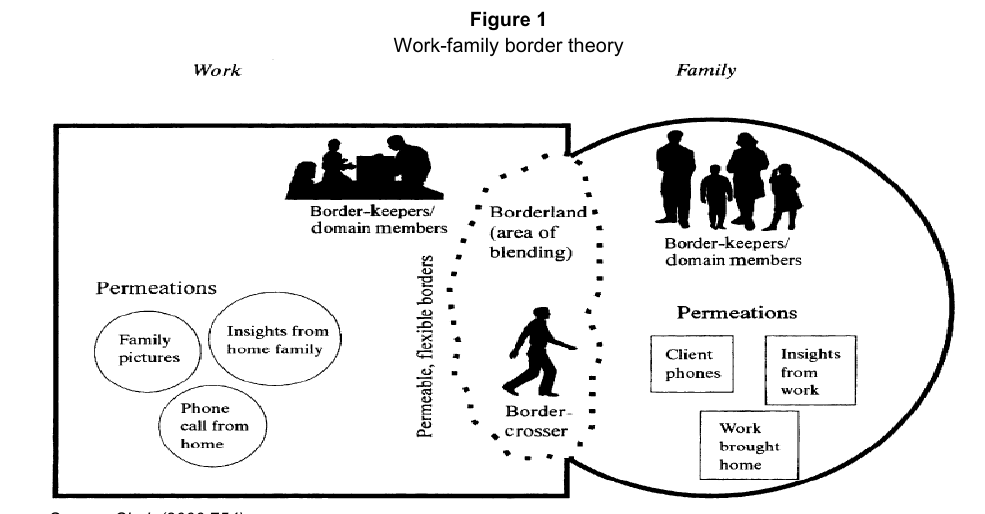
Work-family border